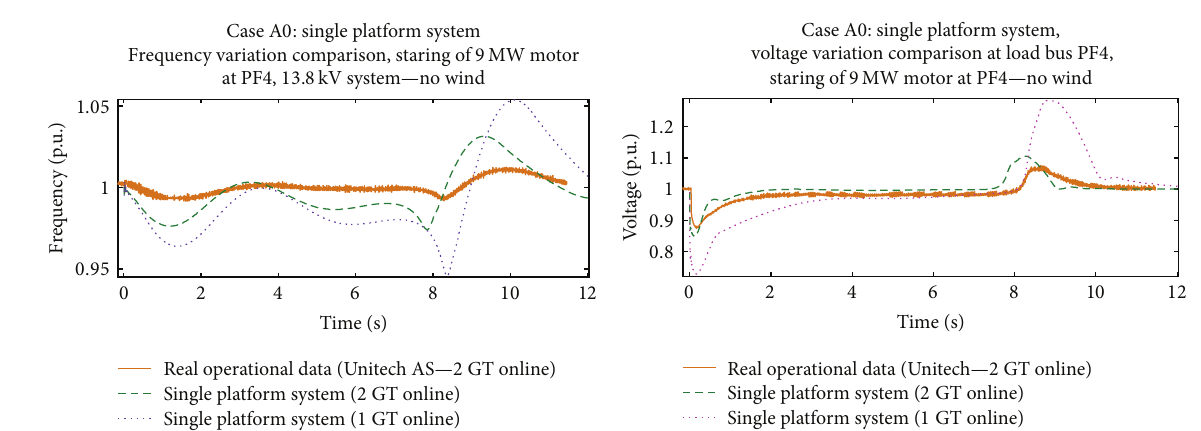
Figure 9: Comparison of the frequency and voltage variation with the measurement